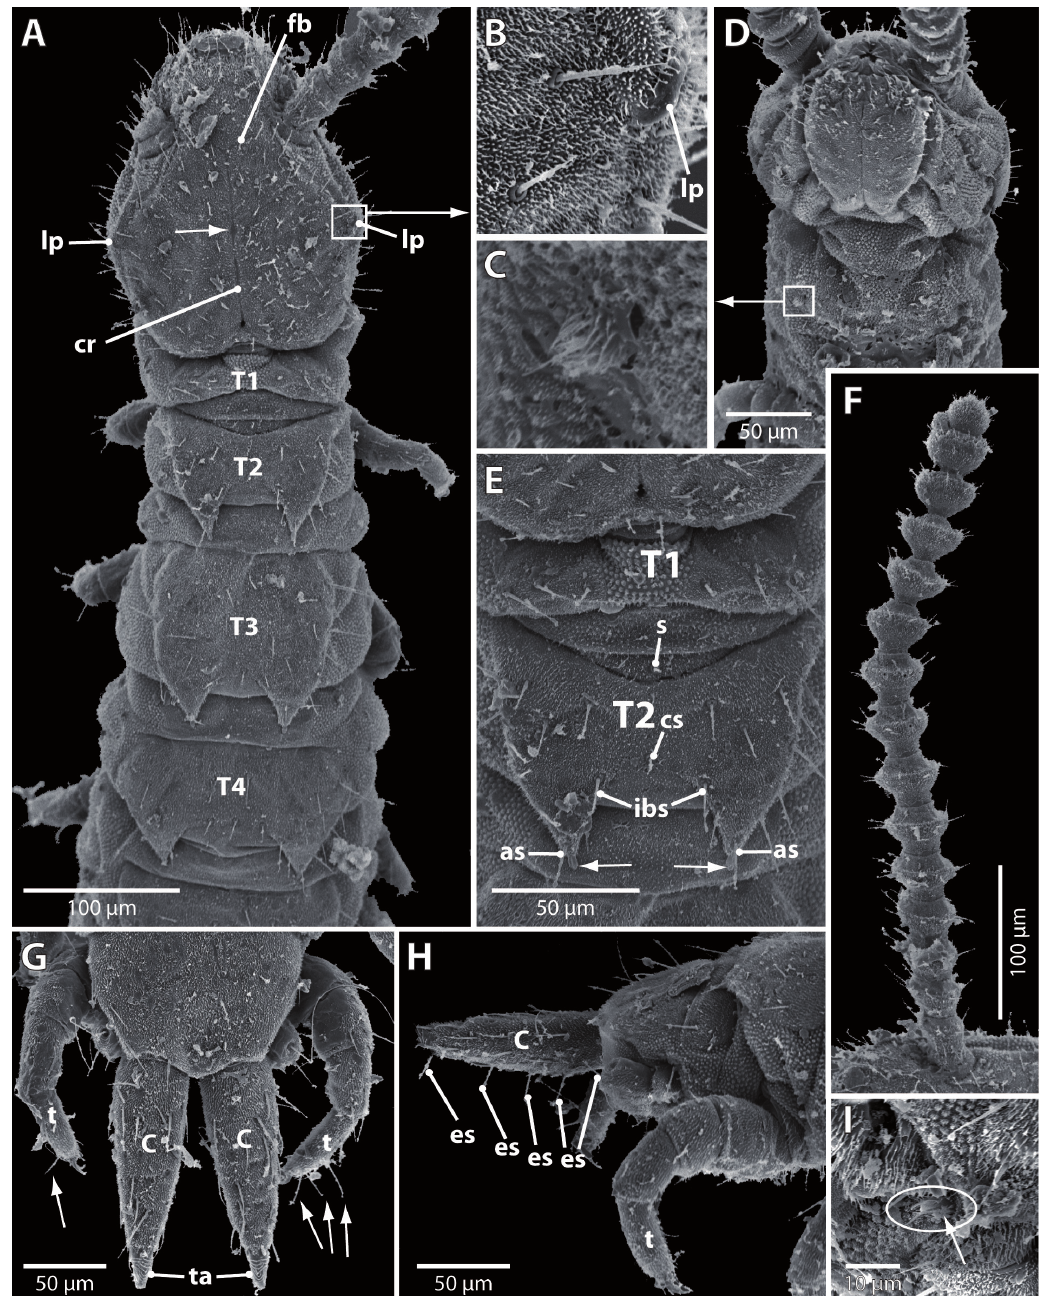
Fig. 3. Symphylella kalundu sp. nov., holotype (dorsal views) and paratype (ventral and lateral views). A . Head and first 4 tergites ( T1, T2, T3, T4 ), dorsal view. Arrow: node in the middle of the central rod ( cr ); fb , frontal branches, lp , lateral protuberance of the head. B . Detail of the surface of the head and lateral protuberance ( lp ). C . Detail of the first leg. D . Head and anterior part of the trunk, ventral view. E . Detail of the first ( T1 ) and second ( T2 ) tergites. Arrows , small end-swelling of triangular processes; as , apical setae; cs , central seta of the posteromarginal setae; ibs , inner basal setae of the posteromarginal setae; s, seta between first and second tergites. F . Right antenna. G . Last tergite, last pair of legs and cerci ( C ), dorsal view. Arrows , longer and erect setae of tarsus ( t ) of last pair of legs; ta , terminal area of cerci. H . Posterior part of the trunk, last right leg and right cercus ( C ), lateral view. Es , erect setae of ventral side of cerci; t , tarsus of last leg, without setae. I . Stylus of the leg 10 ( arrow and circle